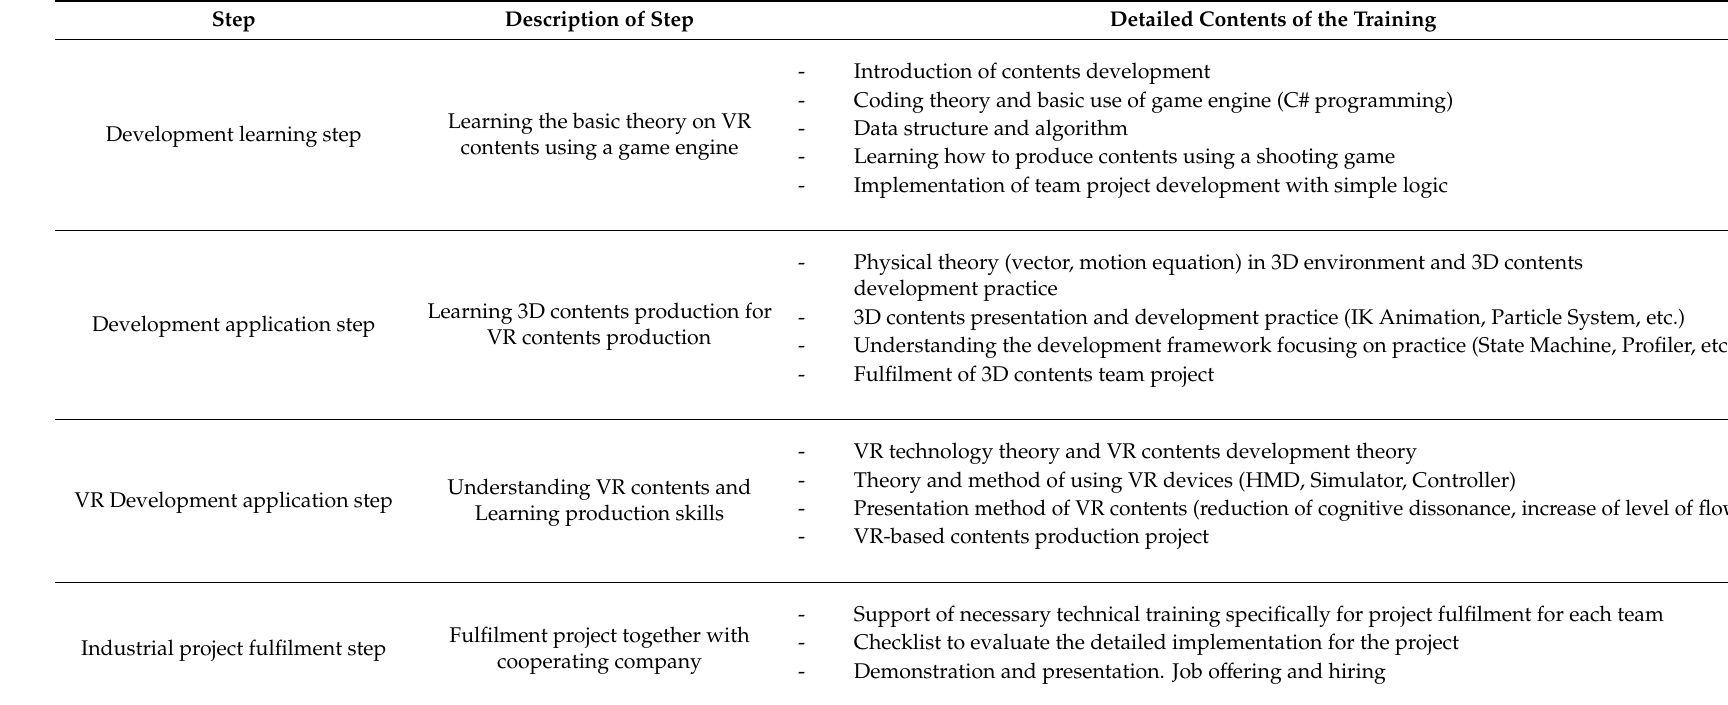
Table 4. Demographic data for the